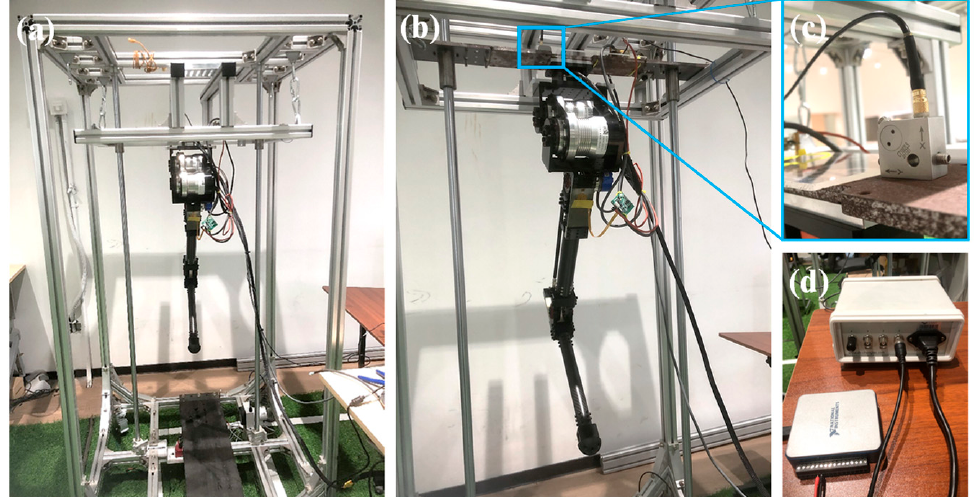
Figure 10. Impact acceleration detection device: ( a ) the single leg assembled on the test platform, ( b ) an enlarged view of the single-leg installation, ( c ) the acceleration sensor, and ( d ) the power supply and data acquisition system.